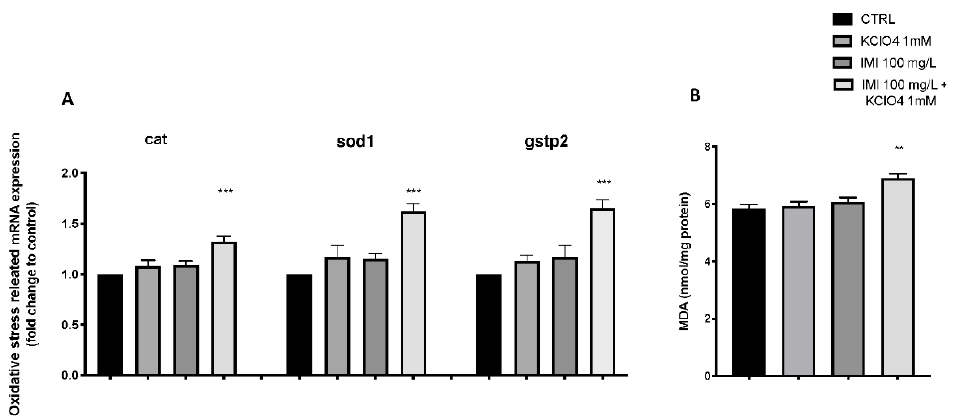
Figure 5. Effects of IMI and KClO 4 single and co-exposure on the mRNA levels of stress oxidative pathway (cat, sod and gstp2) ( A ) in larval zebrafish. MDA ( B ). Values = means ± SEM of three inde- pendent experiment data; ** at p < 0.01 against CTRL. *** at p < 0.001 against CTRL.